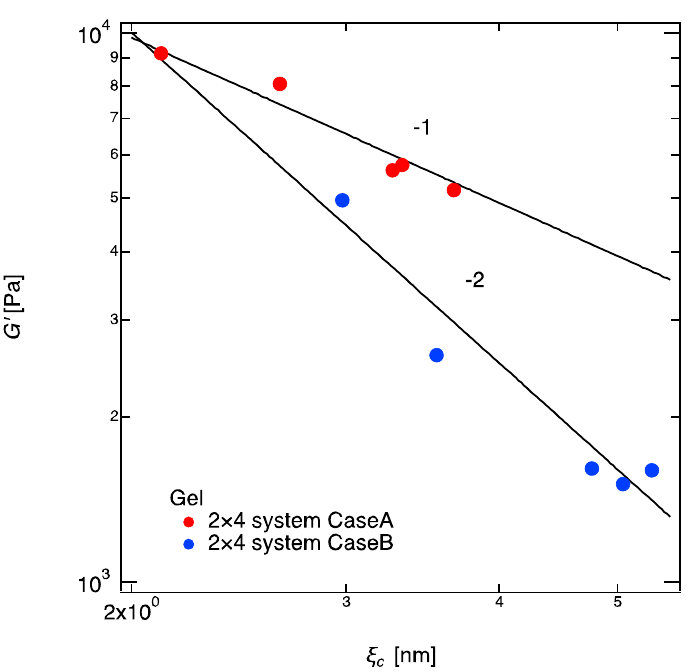
chains between crosslinkers; ( b ) Network with long chains between crosslinkers.